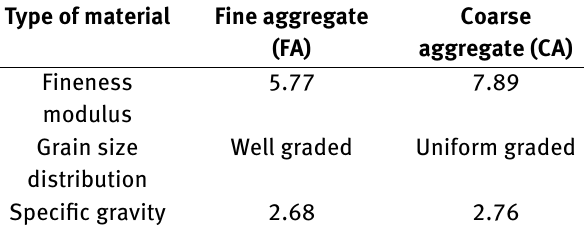
Table 2: Sieve analysis.